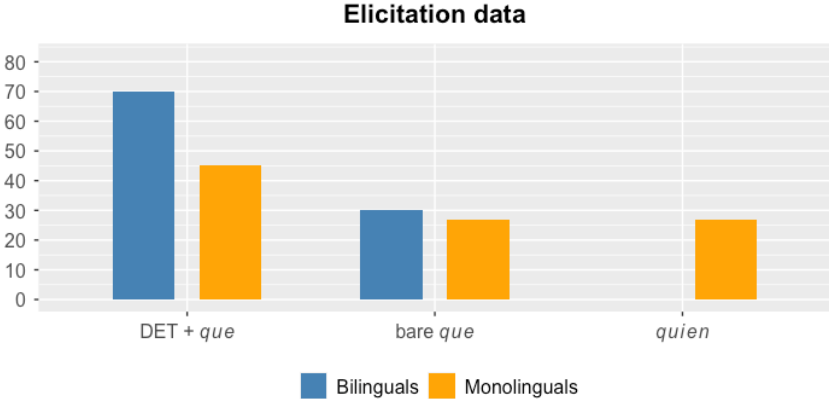
Figure 2. Results for the elicitation cleft data (as a percentage).